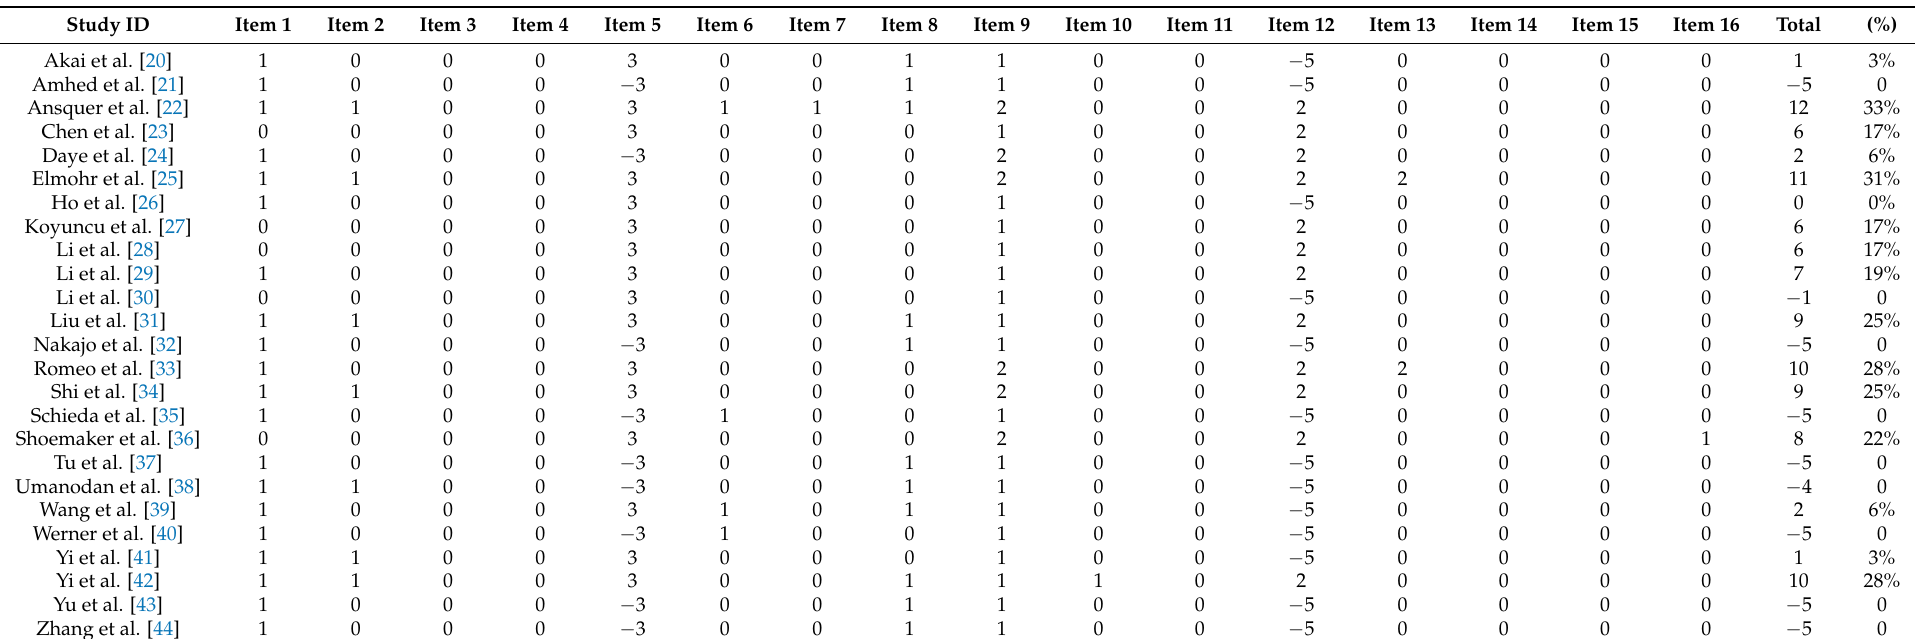
Table 2. Radiomics Quality Score (RQS) assessment for all included